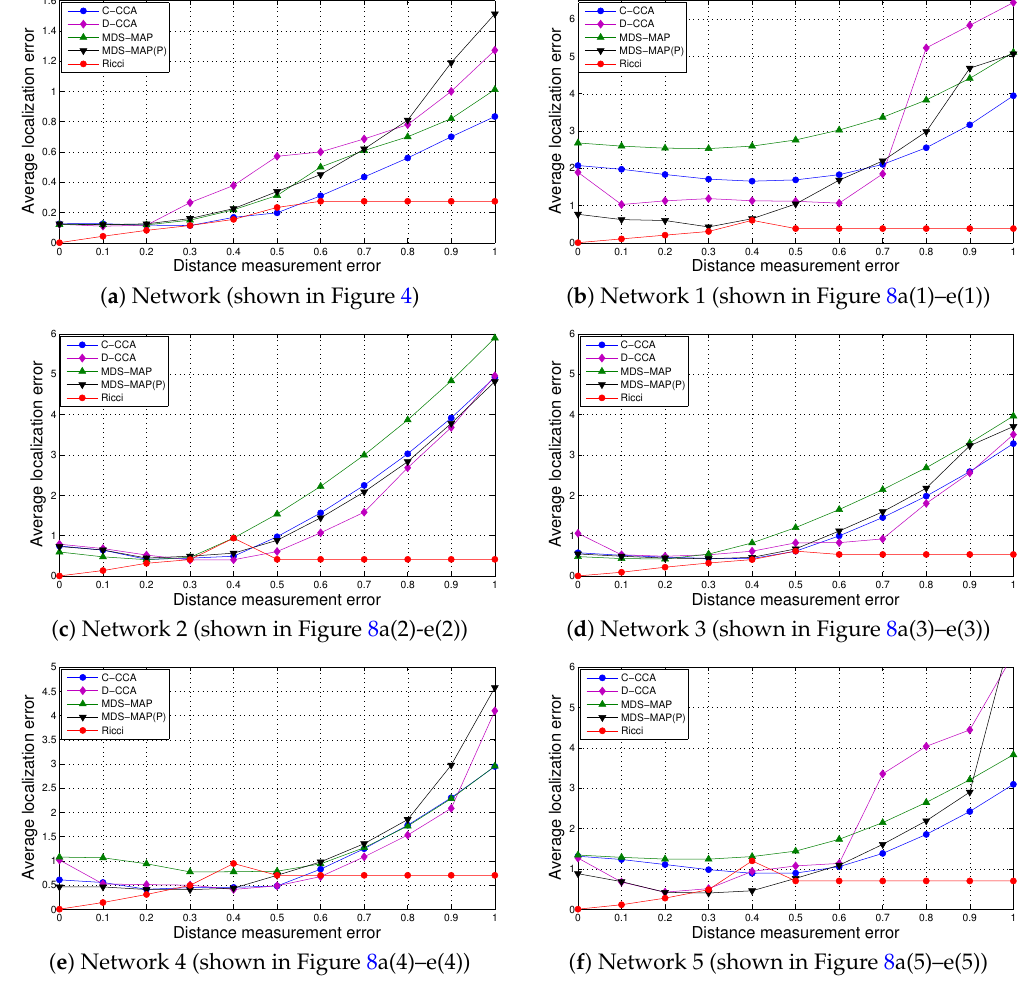
Figure 10. Comparison of average localization errors of different methods on networks shown in Figures 4 and 8 with one-hop communication radio range distance measurement errors increased from